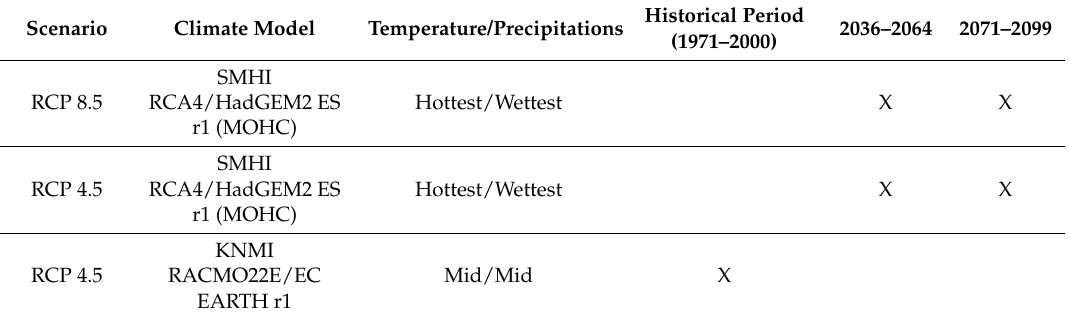
Table 1. Study models